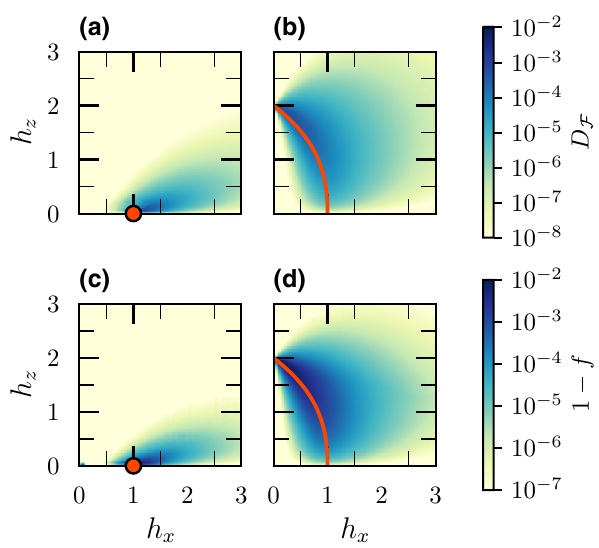
FIG. 2. Top row: interaction distance for the ground state of the (a) FM and (b) AFM models in Eq. (10) as a function of fields h x and h z . Bottom row: the infidelity 1 − f of the QAOA protocol for the (c) FM and (d) AFM models. See the text for details of the QAOA protocol. All data are for system size N = 8 using PBCs. Red circles denote critical point of the FM model, while red lines are critical line in the AFM model according to Ref.